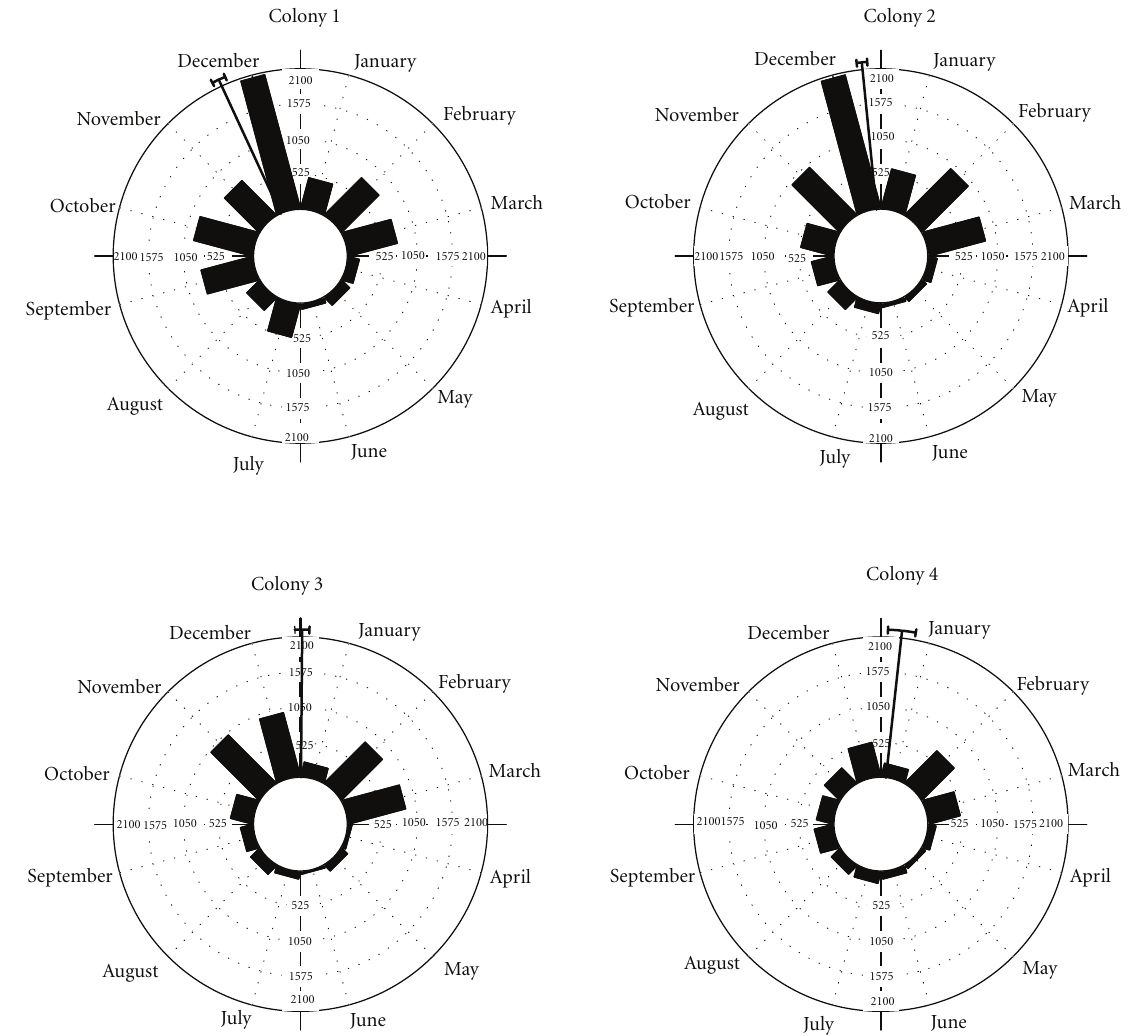
Figure 4: Circular analysis of the number of pollen foraging workers of Scaptotrigona a ff . depilis for each colony. Each month represents 30 ◦ of the circle, and each bar represents the number of returning pollen workers. The line at the top of the vector indicates the standard deviation.